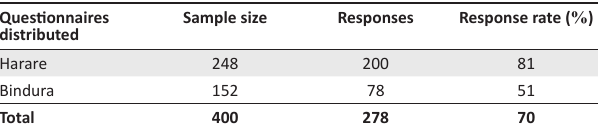
TABLE 1: Questionnaire response rate. Questionnaires